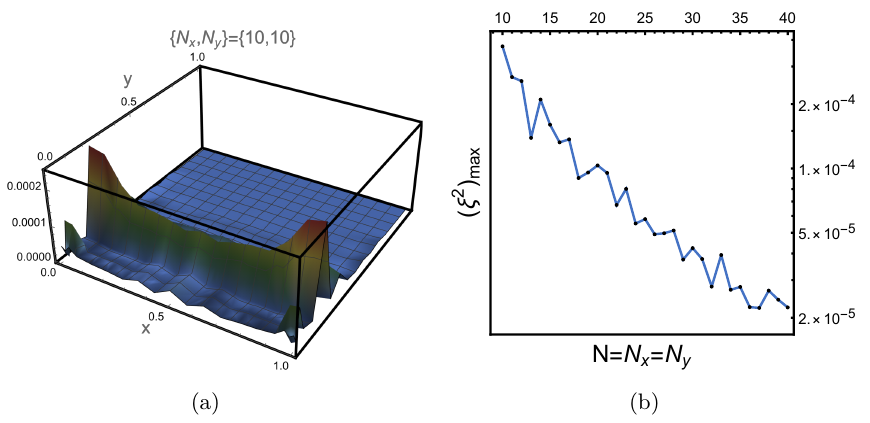
Figure 17 . Numerical convergence test with fixed parameters { L, θ 1 , θ 2 , µ, w 0 } = { 1 , 19 π/ 40 , 19 π/ 40 , 0 , 2 } . (a): norm of the DeTurck vector ξ 2 ( x, y ) with gridpoints { N x , N y } = { 10 , 10 } . (b): maximum of the norm as a function of gridpoints N (= N x = N y )